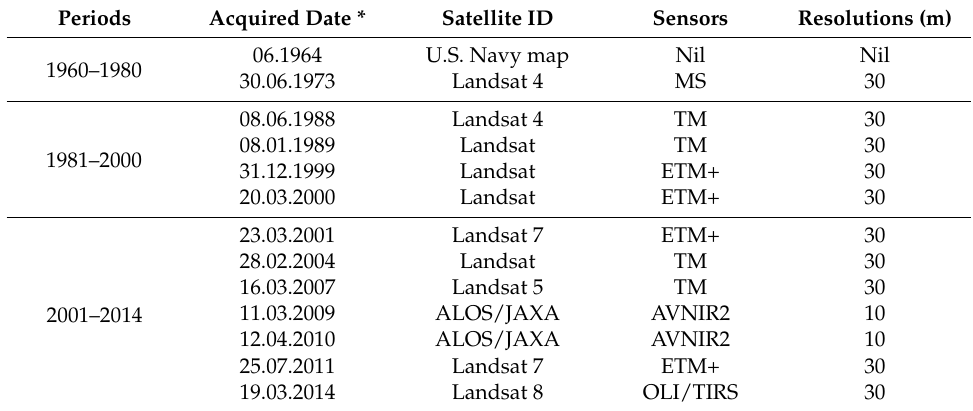
Table 1. Characteristics of acquired multi-spatial satellite images used for the shoreline change study.